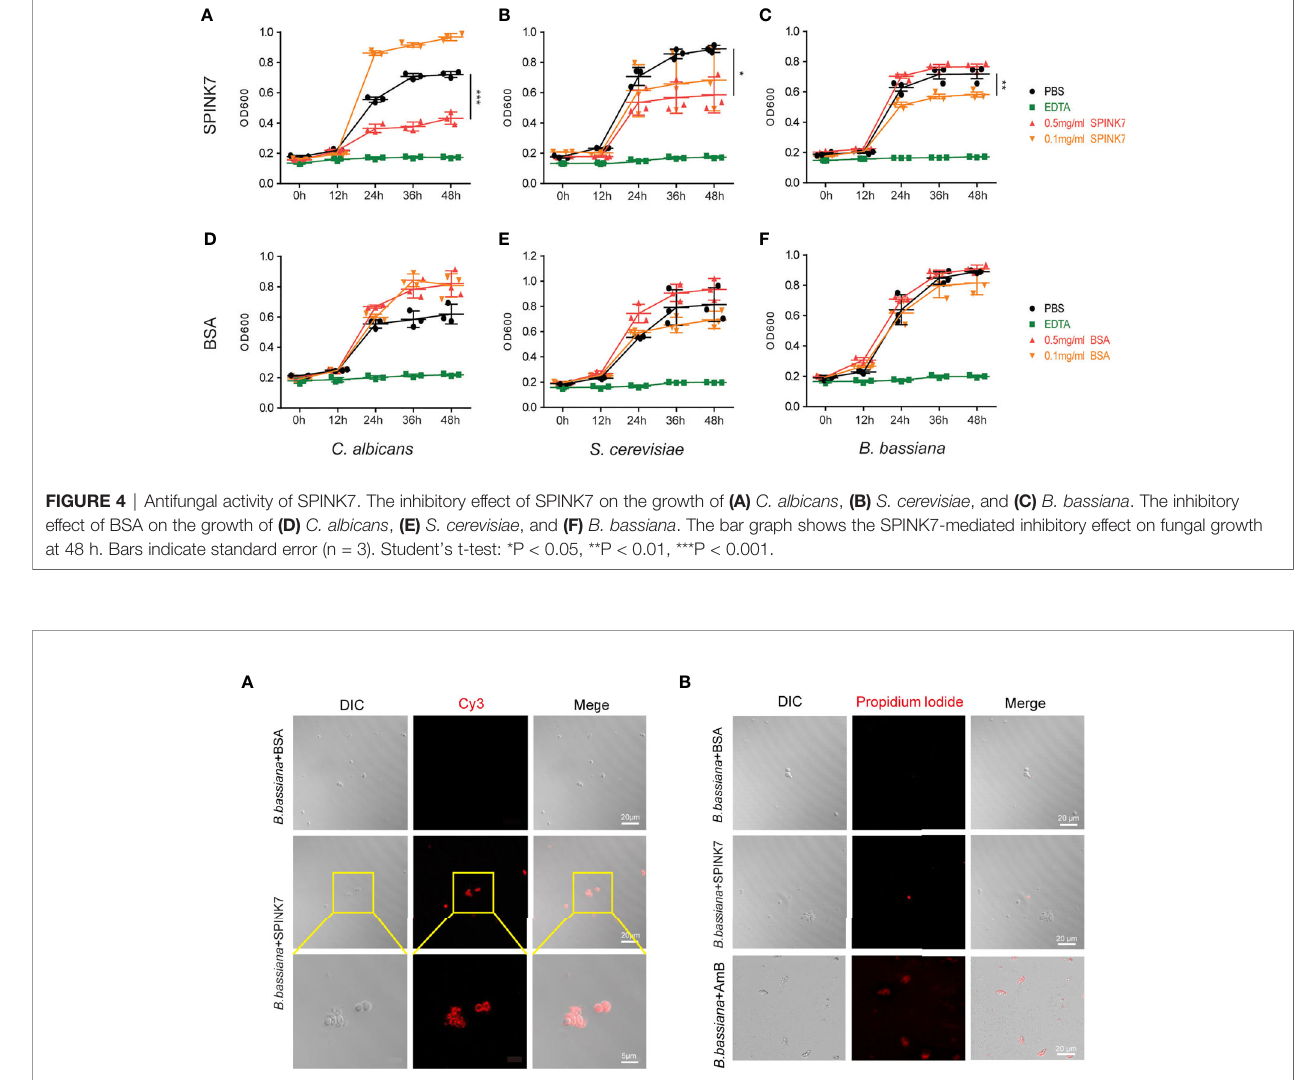
FIGURE 5 | Interaction between SPINK7 and B. bassiana spores. (A) Immuno fl uorescence visualization of SPINK7 binding on the surface of B. bassiana spores. SPINK7 was preincubated with B. bassiana spores, and then incubated with anti-SPINK7 antibodies followed by a secondary antibody labeled with Cy3 (red). (B) Photomicrographs of B. bassiana spores stained with propidium iodide after treatment with amphotericin B (AmB) or BSA or SPINK7. Red (propidium iodide) indicates cells with ruptured